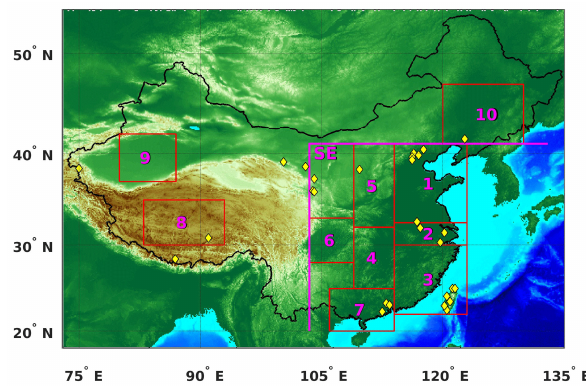
Figure 2. Regions over mainland China (indicated by the purple numbers and red borders) selected for the study of the seasonal, interannual and long-term behavior of the AOD, and the locations of the Aerosol Robotic Network (AERONET) sites (yellow diamonds) used in this study for validation. The black line indicates mainland China. A larger area over southeastern China is indicated as “SE” and denoted using a purple